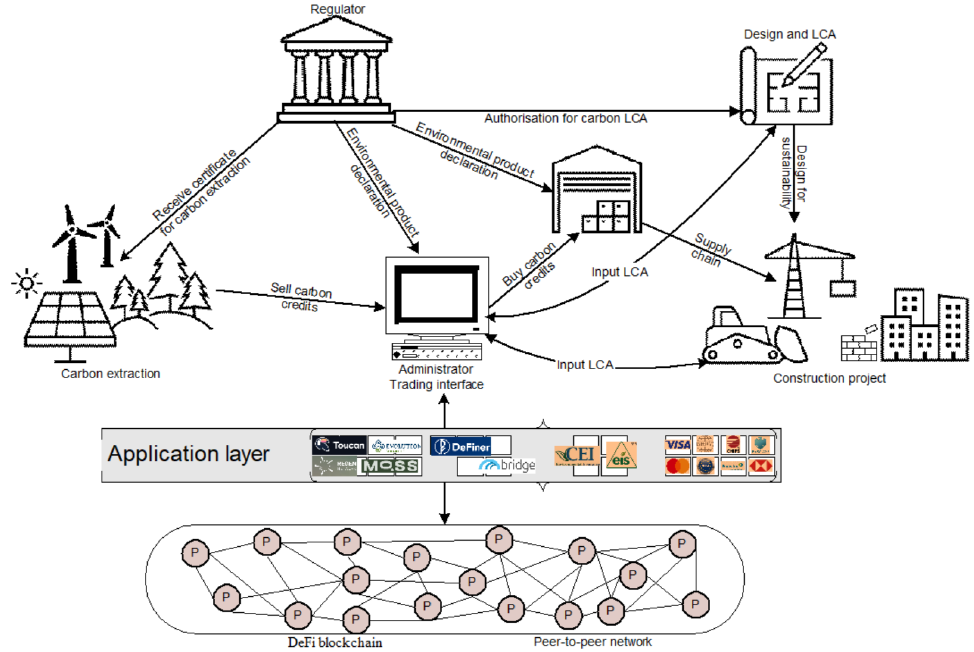
Figure 4. This diagram shows the trading network comprising the project administrator, govern- ment regulator, LCA analysis, supply chain network, financial, services, and blockchain technology (© G . M . C . B